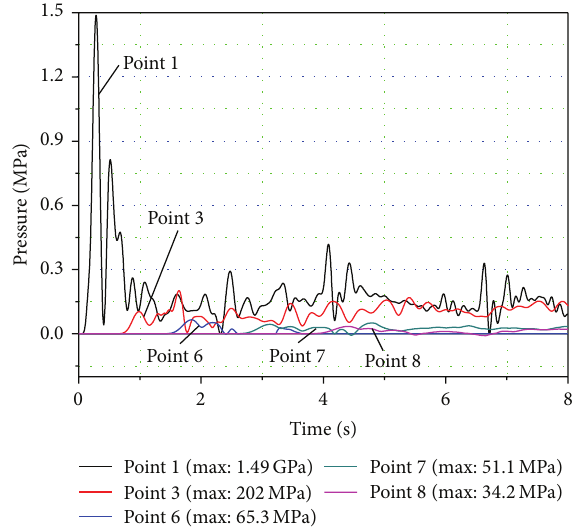
Figure 9: Pressure versus time of the elements in different positions.